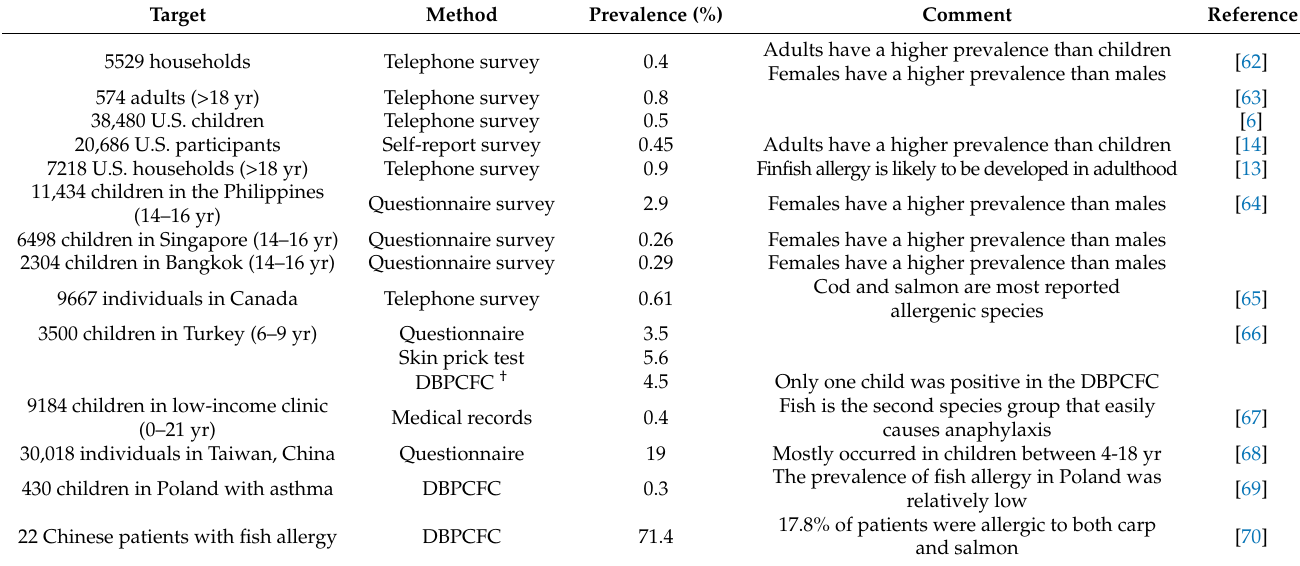
Table 1. Prevalence of fish